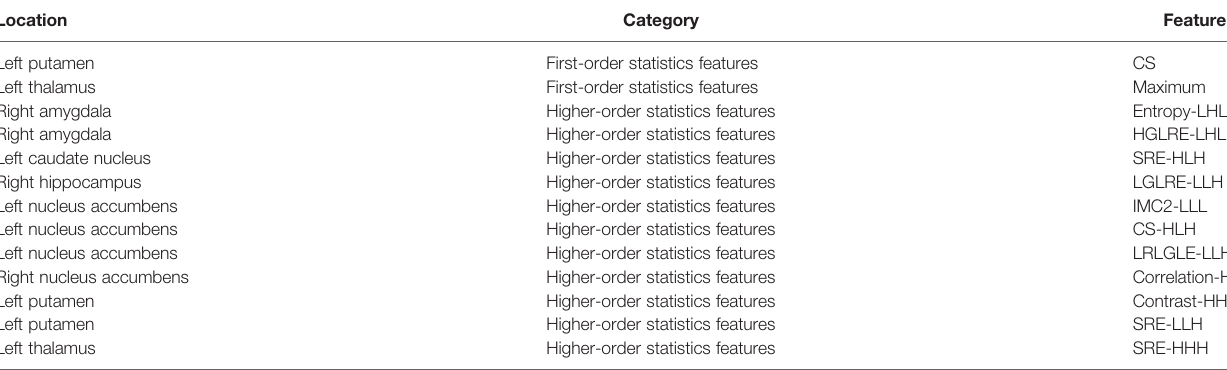
TABLE 2 | The radiomics features in the optimal